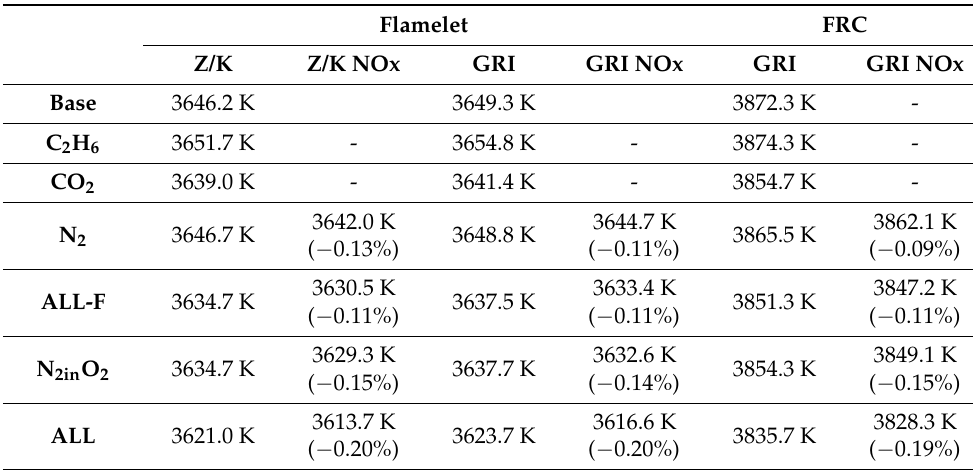
Table 13. Maximum combustion temperature for different pollutants of the fuel and/or the oxidizer and different combustion modelling at 10 MPa (CFD simulation).